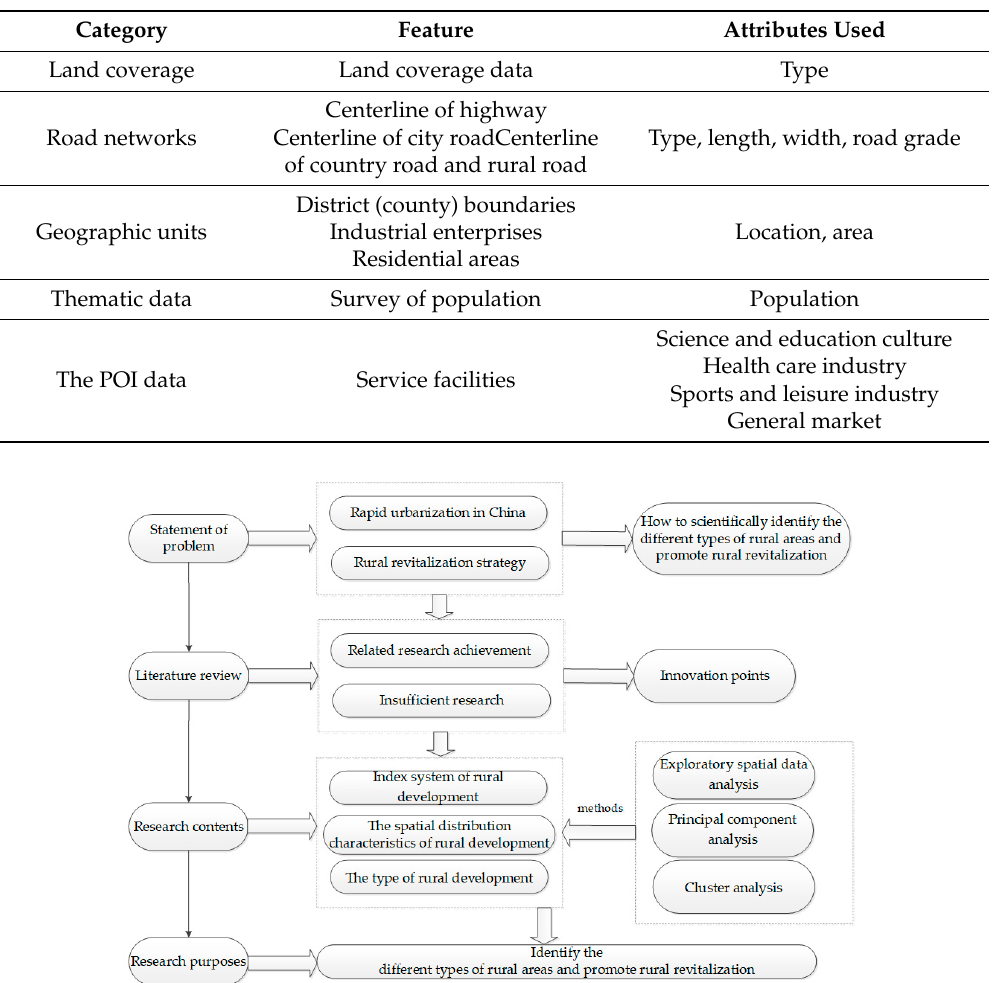
Table 1. List of Wuhan geographical conditions census data used in this study.